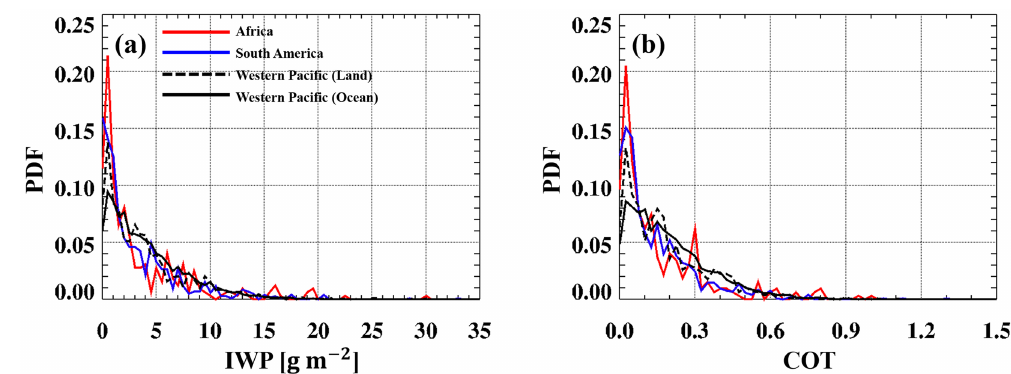
Figure 10. Same as Fig. 3 but for extinction coefficient.